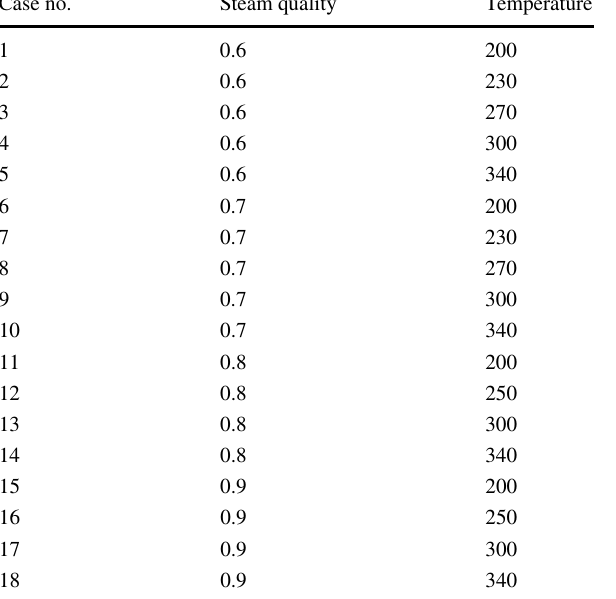
Table 12 SG open and stop times optimization cases Case